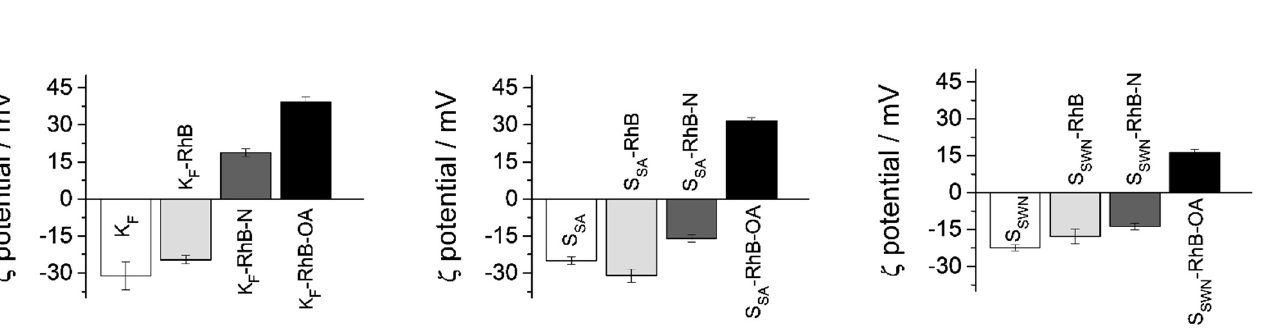
Figure 4. Zeta ( ζ ) potential values of all of the model organonanoclays. The increasing darkness in bar colors corresponds to the progressive synthesis steps: from bare clays to loaded, APTES- functionalized and final OA-functionalized organonanoclays (white, light gray, dark gray and black bars,